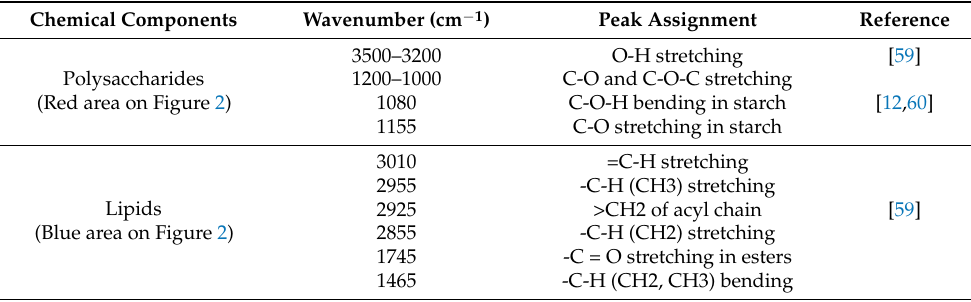
Table 1. Peak assignments of the FTIR-HTS spectra in the algal cells in experiment 1 (main chemical components are marked on Figure